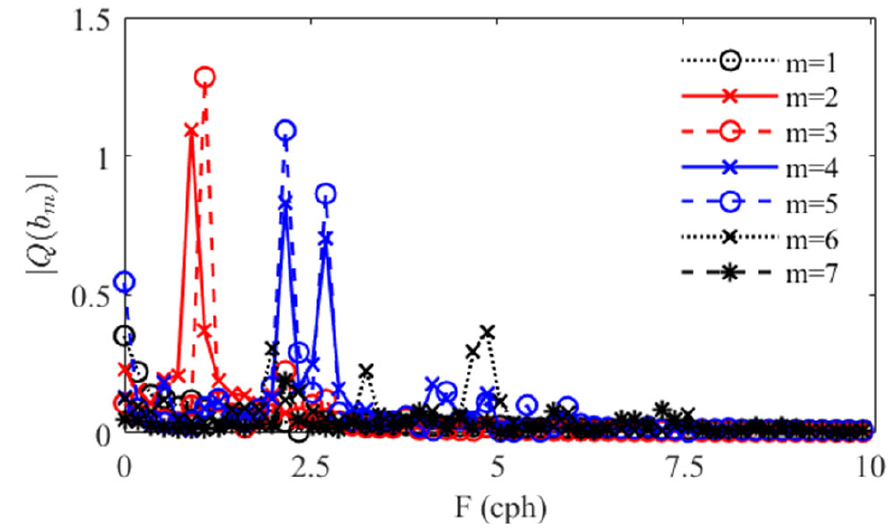
Figure 17. Spectra of mode amplitudes b m ( r e ) for modes 1–7.